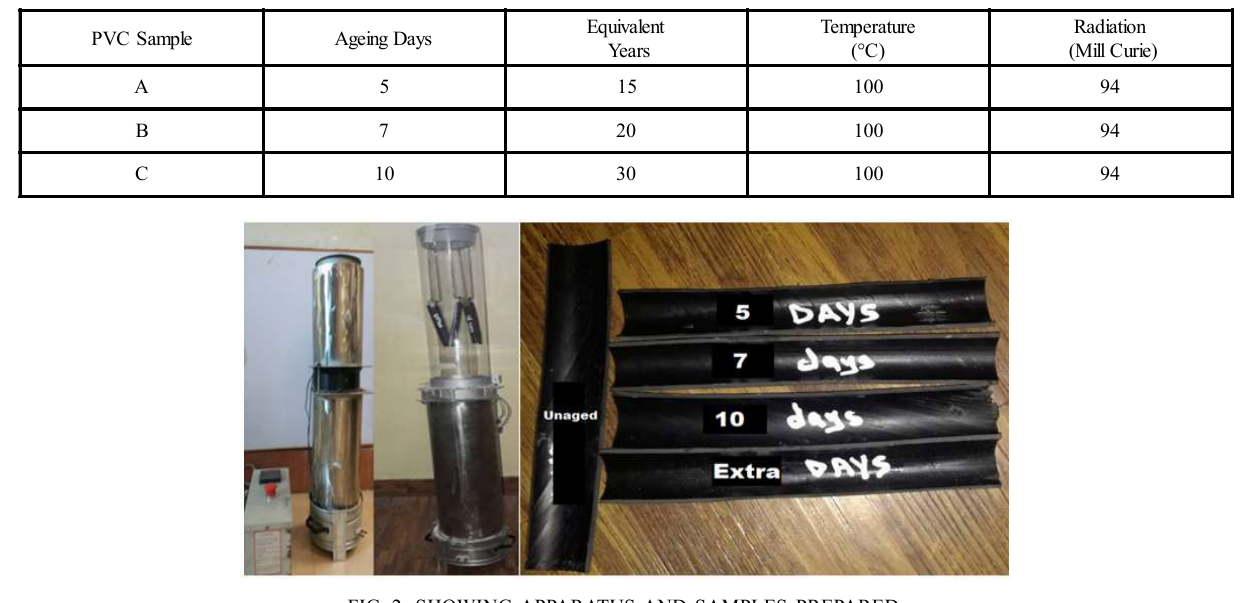
FIG. 2. SHOWING APPARATUS AND SAMPLES PREPARED.